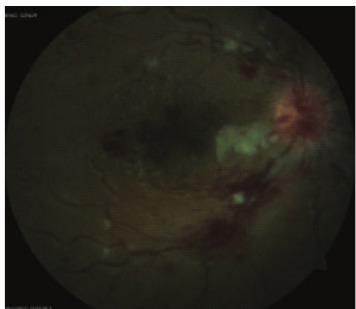
Figure 4: Fundus photograph of the right eye one week after the initial examination.